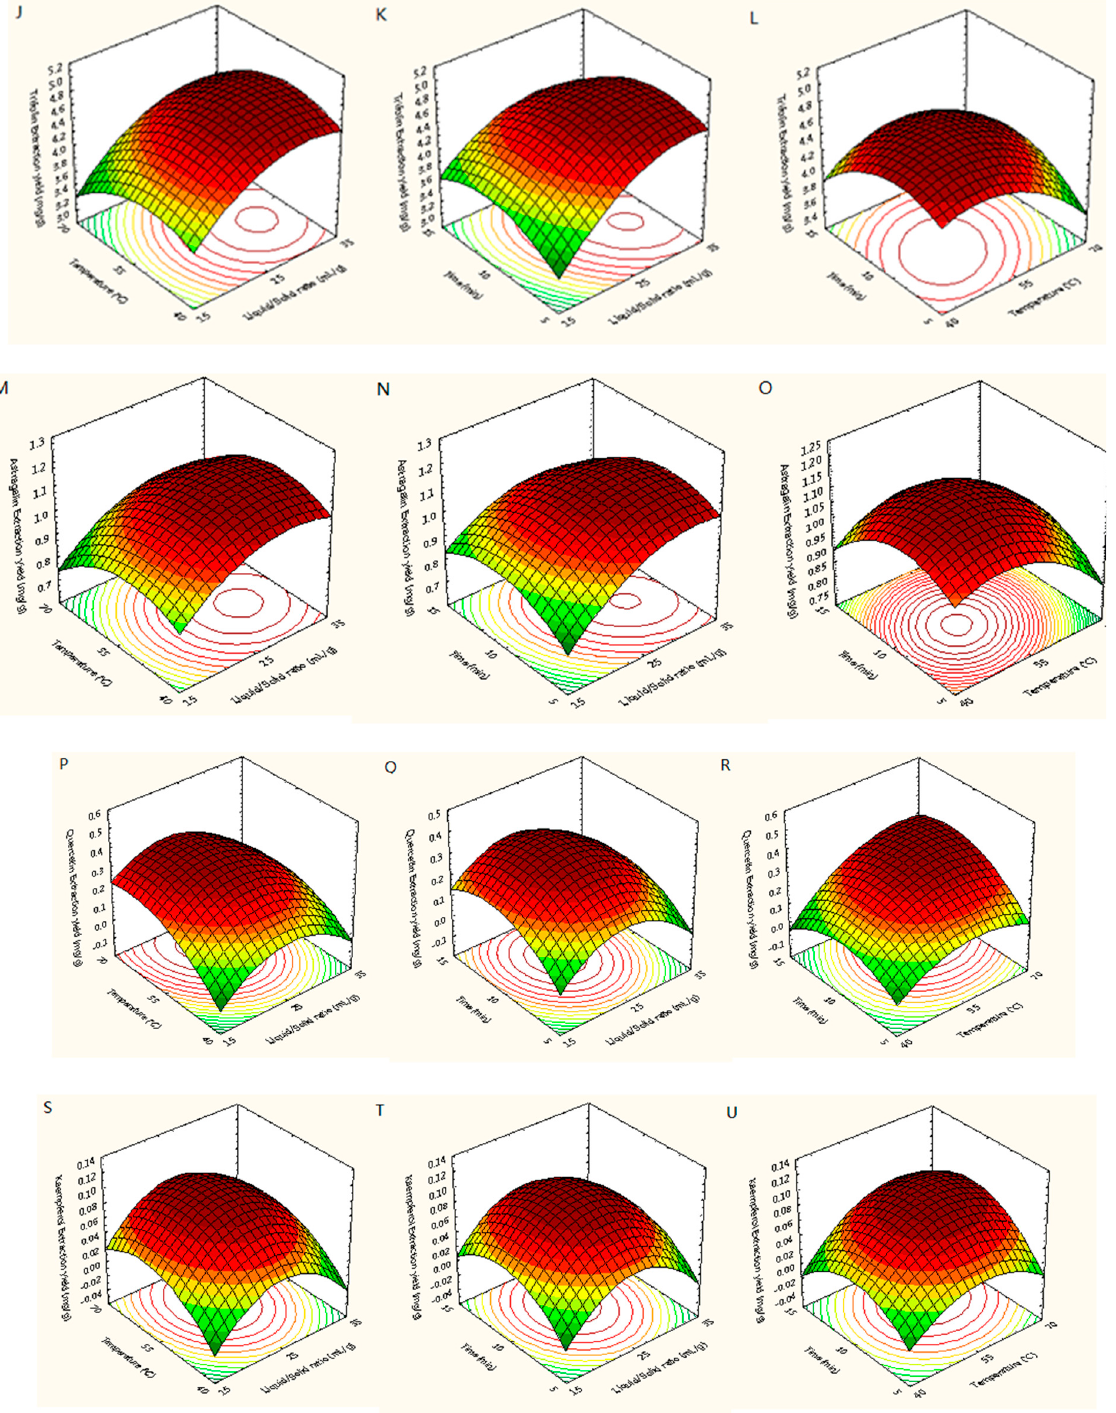
Figure 5. Response surfaces for extraction yields of rutin ( A − C ), hyperoside ( D − F ), isoquercetin ( G − I ), trifolin ( J − L ), astragalin ( M − O ), quercetin ( P − R ), and kaempferol ( S − U ) from Ribes mands- trifolin ( J – L ), astragalin ( M – O ), quercetin ( P – R ), and kaempferol ( S – U ) from Ribes mandshuricum huricum leaves.